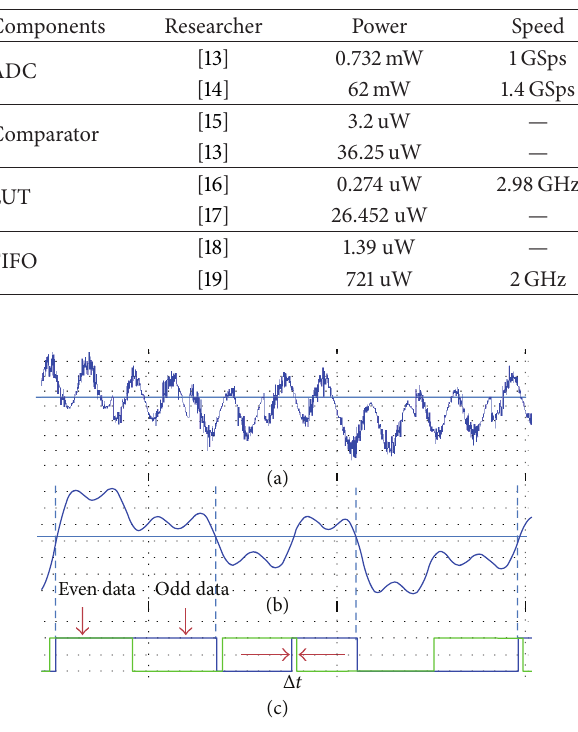
Table 4: Power comparison for various components in QPSK demodulator.